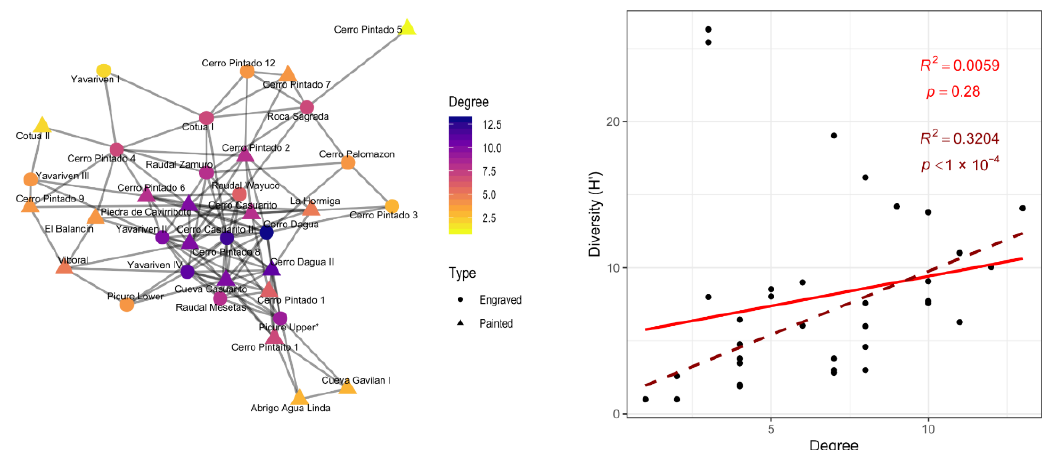
Figure 5. Visualisation of stylistic similarity as a network. ( a ) Network of linkages where Jaccard similarity is ≥ 0.1, a threshold introduced to reduce over-plotting. Points are coloured by their degree (number of links). ( b ) Rock art site diversity does not correlate strongly with its degree in the network (light red), unless the largest and most diverse sites are excluded (dark red). The level of correlation remains relatively low and the most connected sites have moderate true diversity scores.